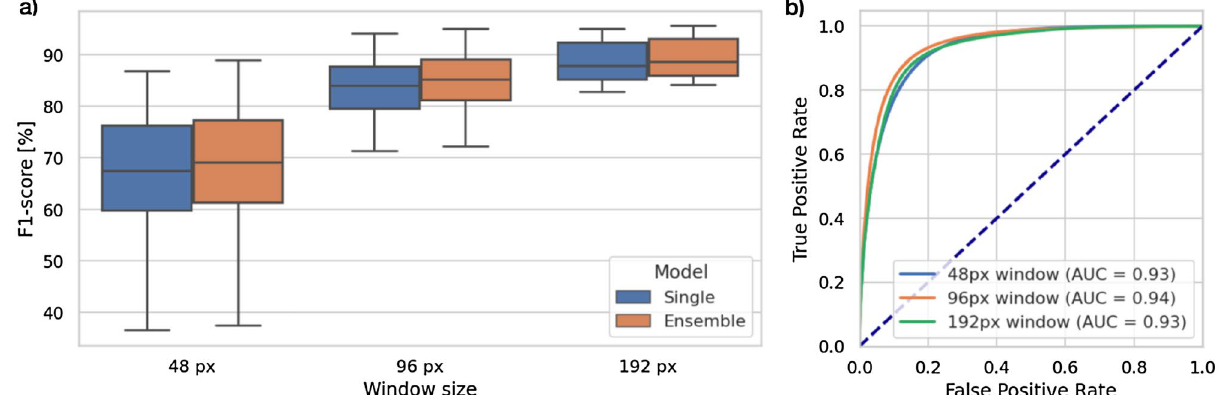
Figure 4. The results of fragments classification: ( a ) F1-score medians and their distributions of compared methods evaluated on 20 images from the testing chunk, ( b ) AUROC (area under the receiver operating characteristics) of the component models (“single”) grouped by the window